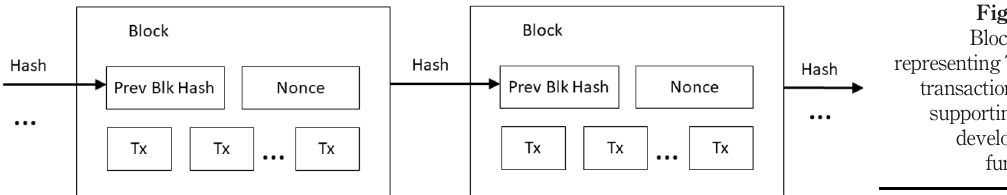
representing TADA transactions (Tx) supporting SSA development